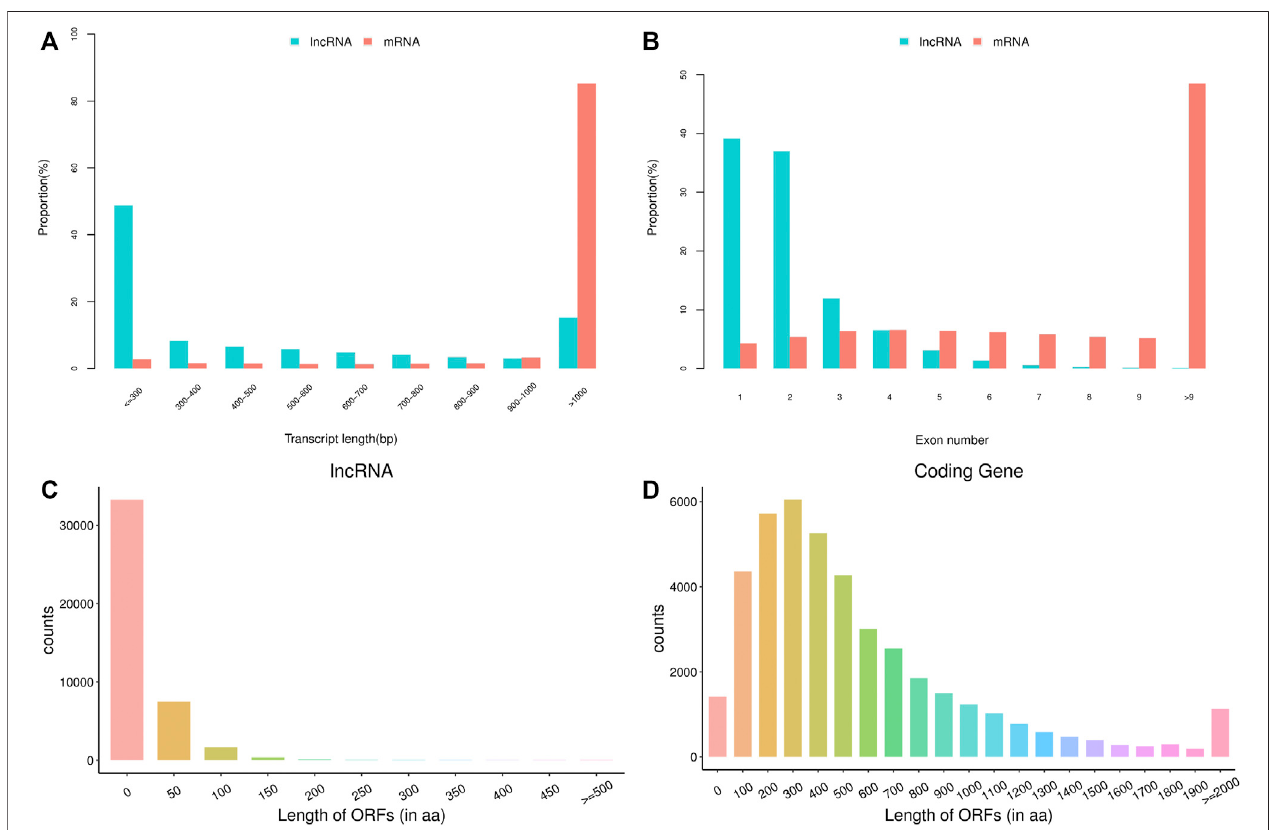
FIGURE 1 | The basic features of predicted long non-coding RNAs (lncRNAs) and mRNAs. (A) transcript length of lncRNAs and mRNAs, (B) exon number of lncRNAs and mRNAs, (C) open reading frame (ORF) length of lncRNAs, (D) ORF length of mRNAs.